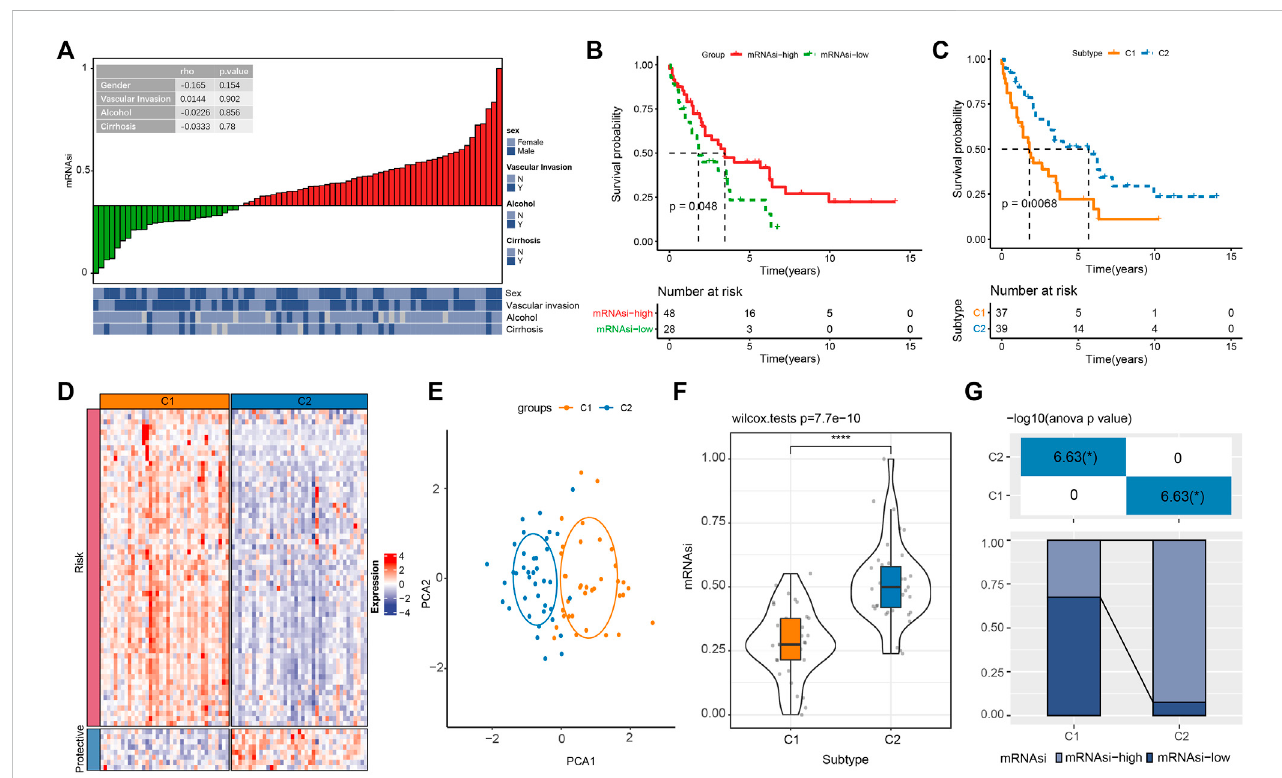
FIGURE 1 The relation between mRNAsi and the prognosis of cholangiocarcinoma in E-MTAB-6389 cohort. (A) Correlation analysis of mRNAsi with clinical features of cholangiocarcinoma patients. (B) Kaplan-Meier survival plot of mRNAsi-high and mRNAsi-low groups. (C) Kaplan-Meier survival plot of C1 and C2subtypes. (D) Heatmapoftheexpression(log2TPM)ofriskgenesandprotectivegenesinC1andC2. (E) PCAplotofC1andC2. (F) ComparisonofmRNAsiin C1 and C2. (G) The distribution of mRNAsi-high and mRNAsi-low groups in C1 and C2. * p < 0.05, **** p <